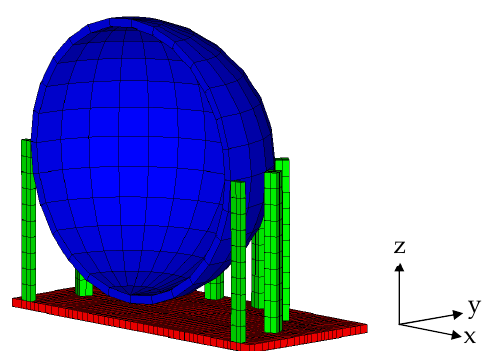
Figure A1. Gas holder modeling.